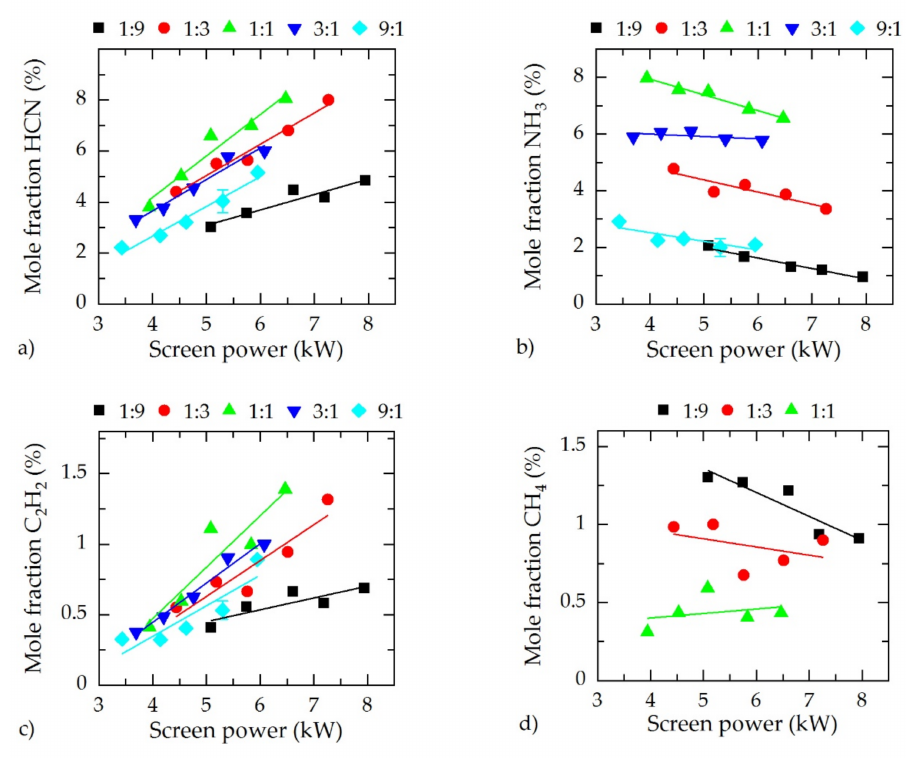
Figure 3. Mole fractions of ( a ) cyanide (HCN), ( b ) NH 3 , ( c ) C 2 H 2 , and ( d ) CH 4 in dependence of the screen power for di ff erent N 2 –H 2 gas compositions.